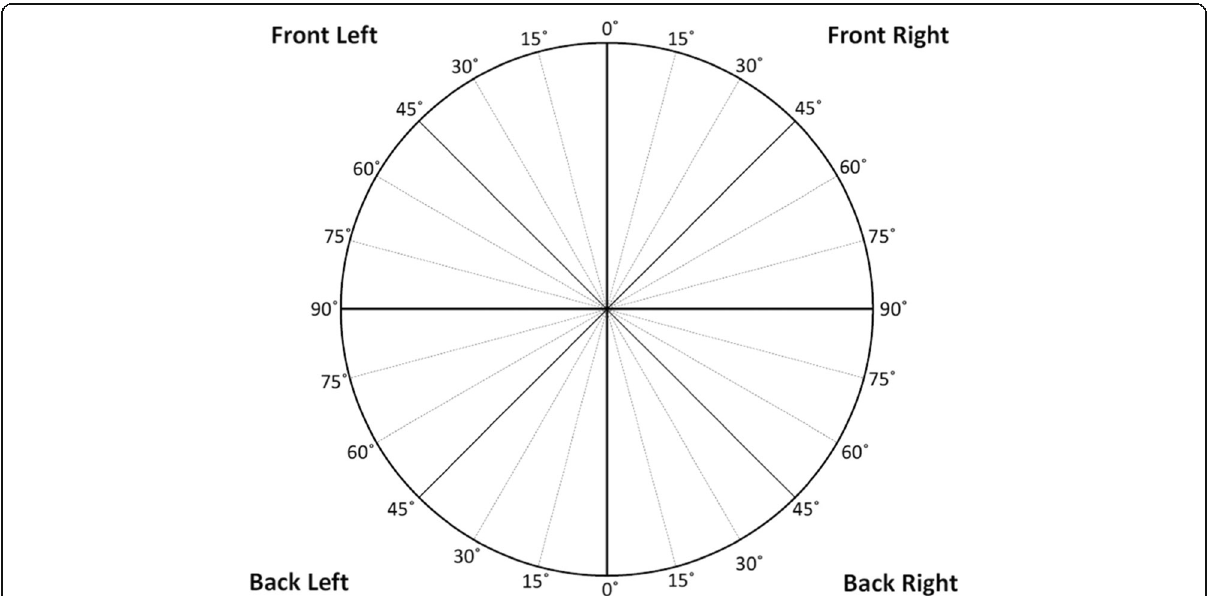
Fig. 7 The response aid used for the pointing